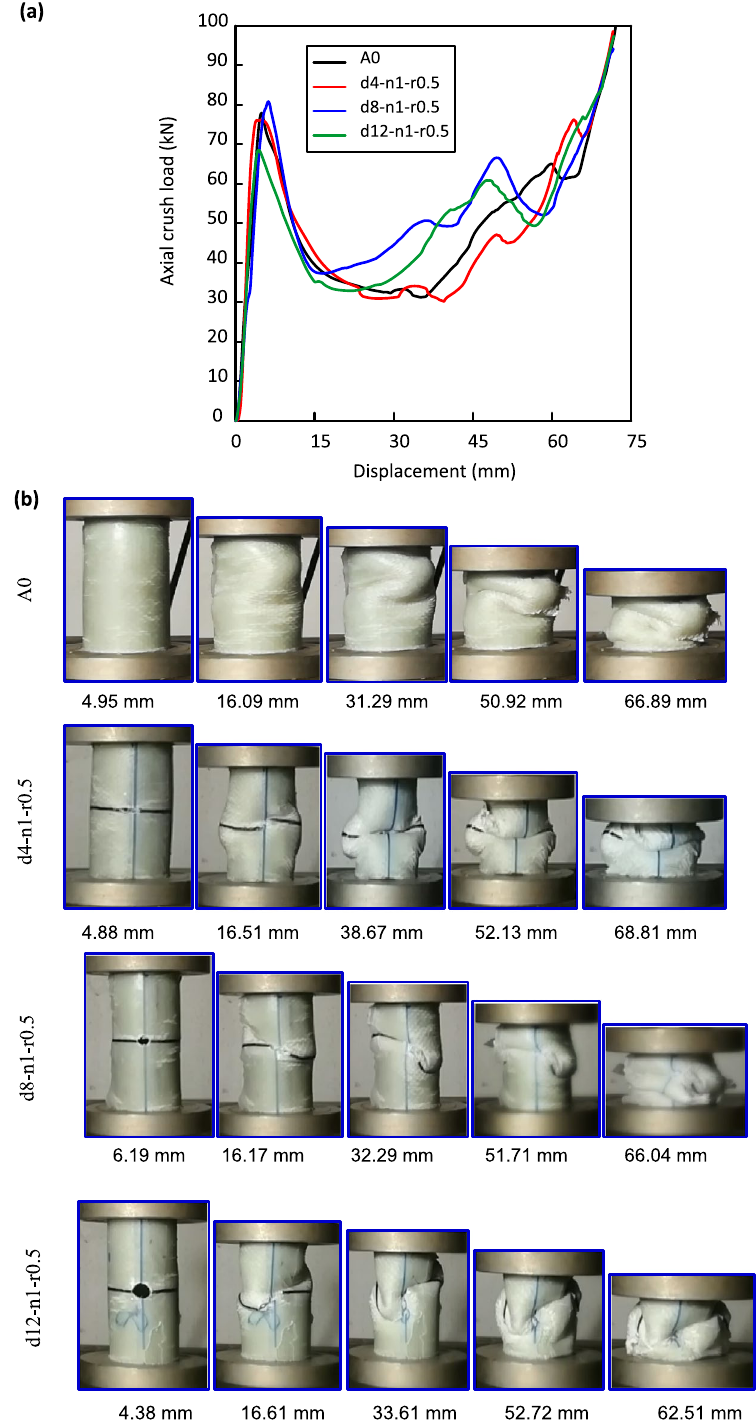
Figure 5. Al/GFRP specimens with different holes’ diameter (d = 0, 4, 8 and 12 mm) ( a ) load–displacement curves, and ( b ) crushing